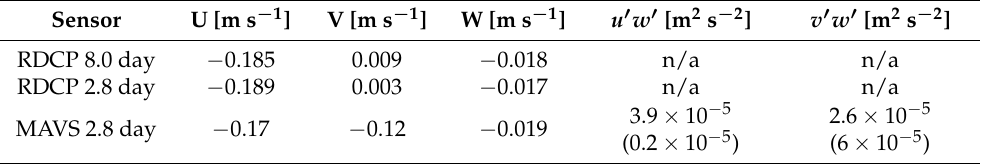
Table 2. Table of momentum: mean ( u , v , w ) and ( u (cid:48) w (cid:48) , v (cid:48) w (cid:48) ) . Turbulent production band